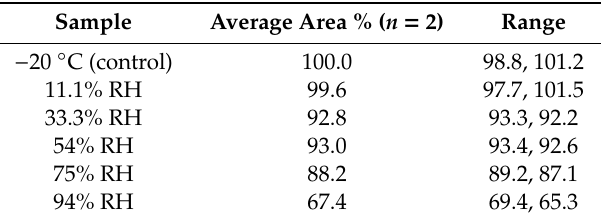
Figure 6. Stability of freeze-dried EGF-Coa. ( a ) Appearances after 2 weeks of storage at various relative humidity at room temperature, ( b ) appearances and dimensions after 4 months of storage at − 18, 4, 25, and 37 °C, ( c ) representative HPLC chromatograms of samples after 4 months of storage at − 18, 4, 25, and 37 °C, and the overlay plots of the same samples, ( d ) in vitro release profiles of samples after 4 months of storage at − 18, 4, 25, and 37 °C . Table 4. Changes in HPLC area % relative to − 20 °C storage sample after 2 weeks of storage in various relative humidity at room temperature.